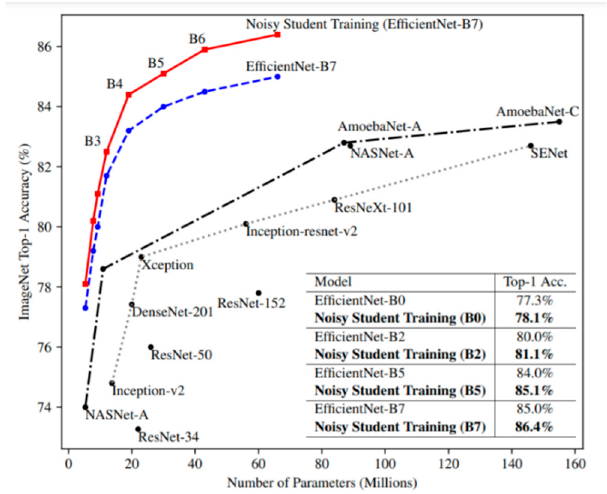
Figure 20. NoisyStudent Training curve w.r.t number of parameters [16].